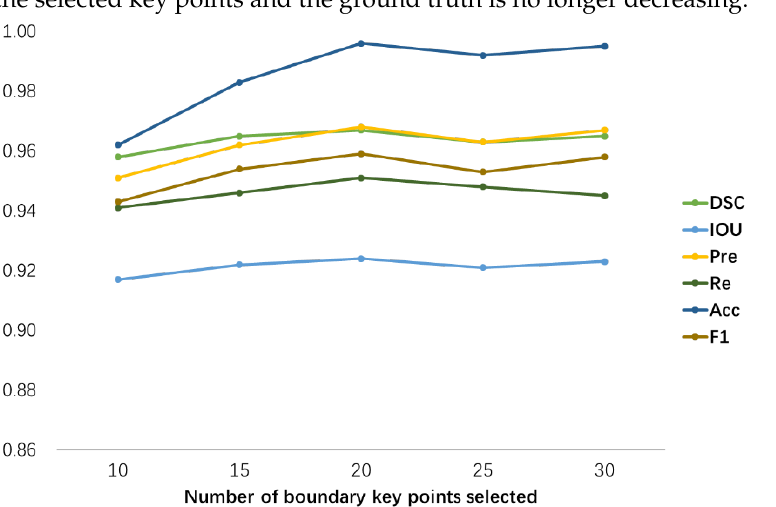
Figure 13. The specific performance of the different number of boundary key points on segmentation evaluation metrics.